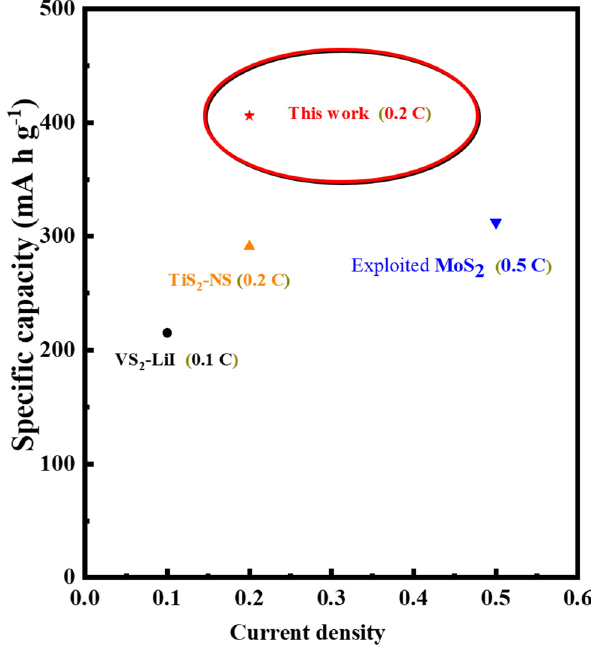
Figure 10. The cycling performance comparison of some sulfide-based electrode in ALLLIBs.